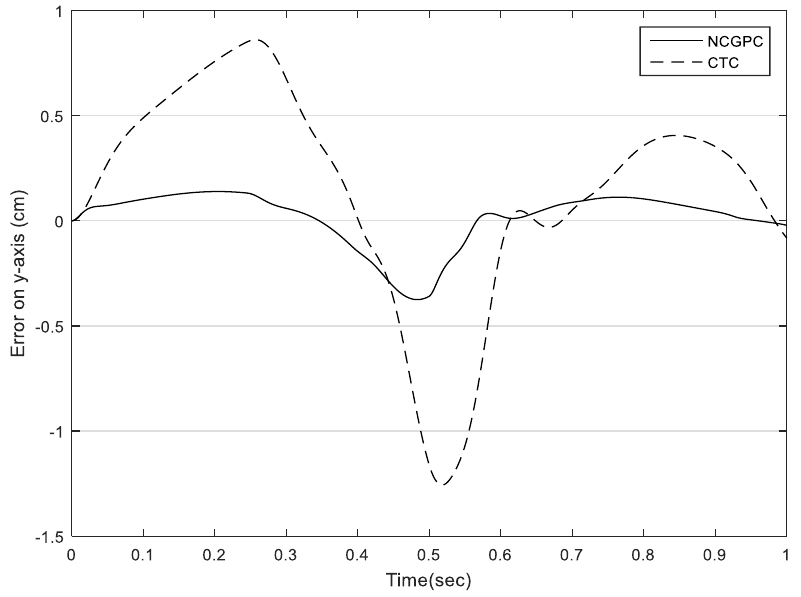
Figure 10. Position tracking errors along Y-direction.